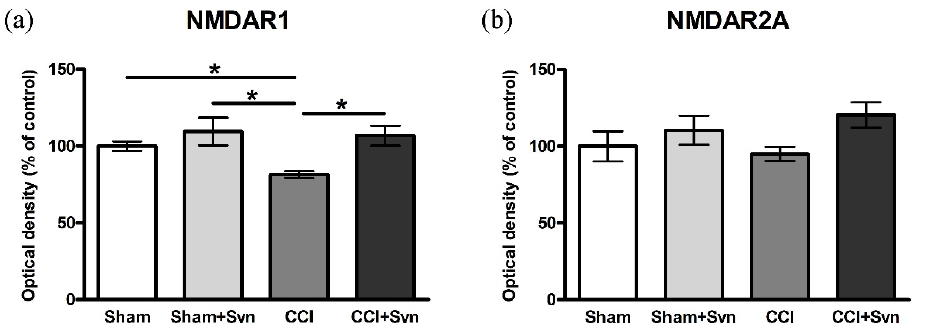
Figure 5. In vivo effect of synaptamide on NMDA receptor in CCI condition. Level of expression of the two subunits of NMDA receptor in the hippocampus: ( a ) NMDAR1 and ( b ) NMDAR2A. Data are presented as mean ± SEM, n = 7/group, * p < 0.05 (one-way ANOVA, post-test Tukey).